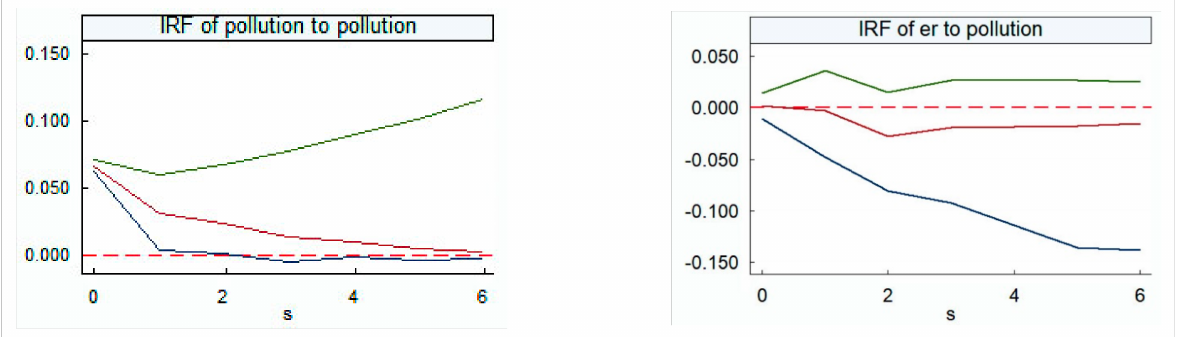
Figure 2. Environmental regulation and pollution emission impulse response diagram. On the left is an impulse response plot of the pollution emissions on itself, and on the right is an impulse response plot of the environmental regulation on pollution emissions. IRF—impulse response function.